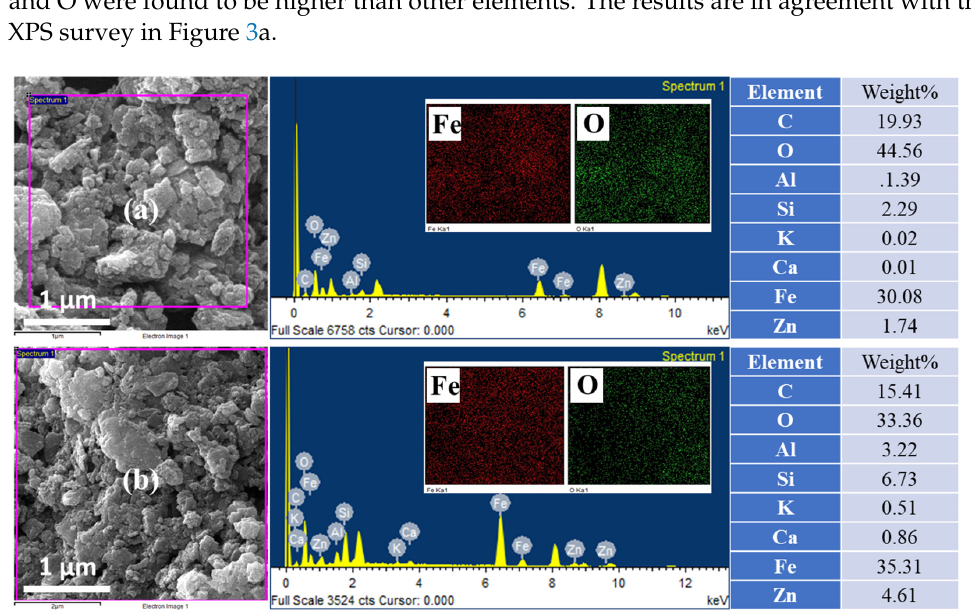
Figure 2. EDX and elemental mapping of ( a ) uncalcined iron rust NPs (top) and ( b ) calcined iron rust NPs (bottom). 200